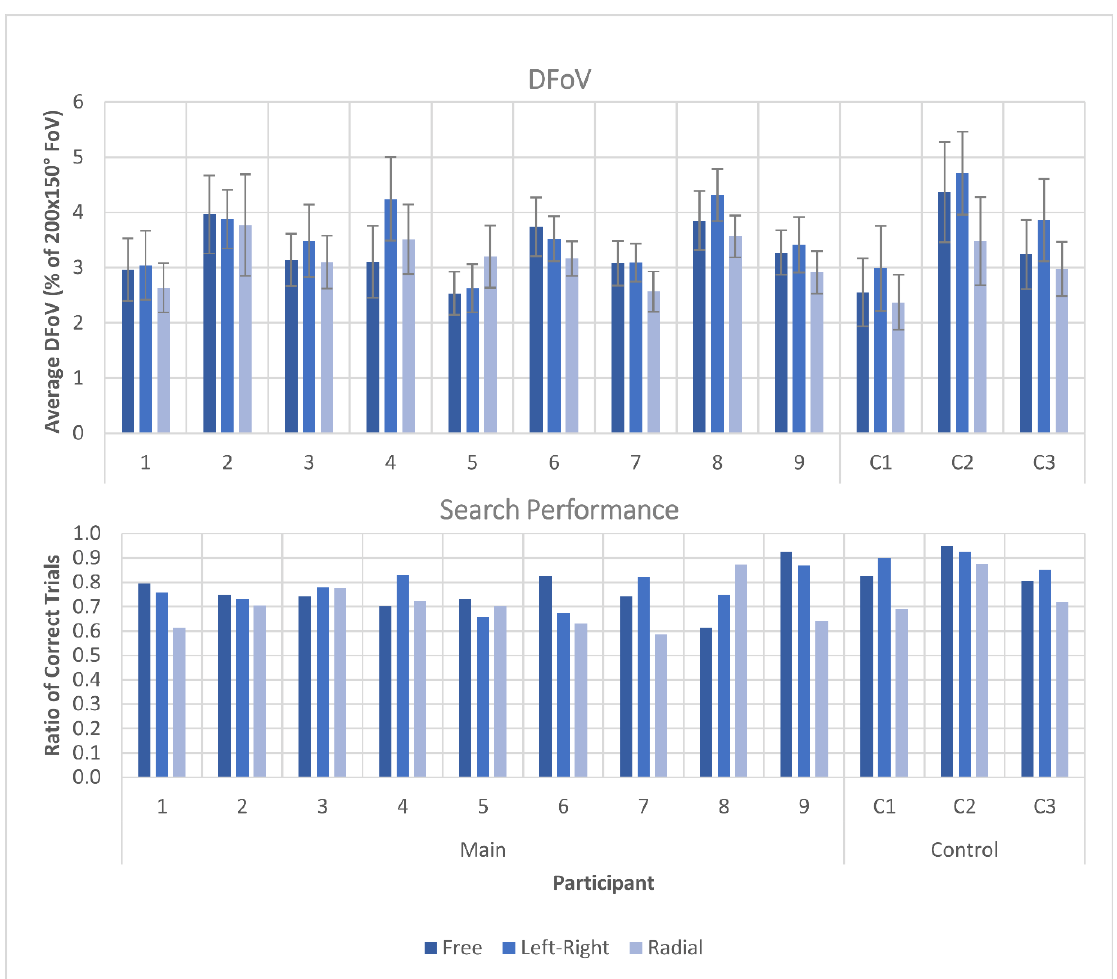
Figure A2. Comparison of DFoV and task performance between individual participants in the search task. Each bar is an average of the results of 40 trials.